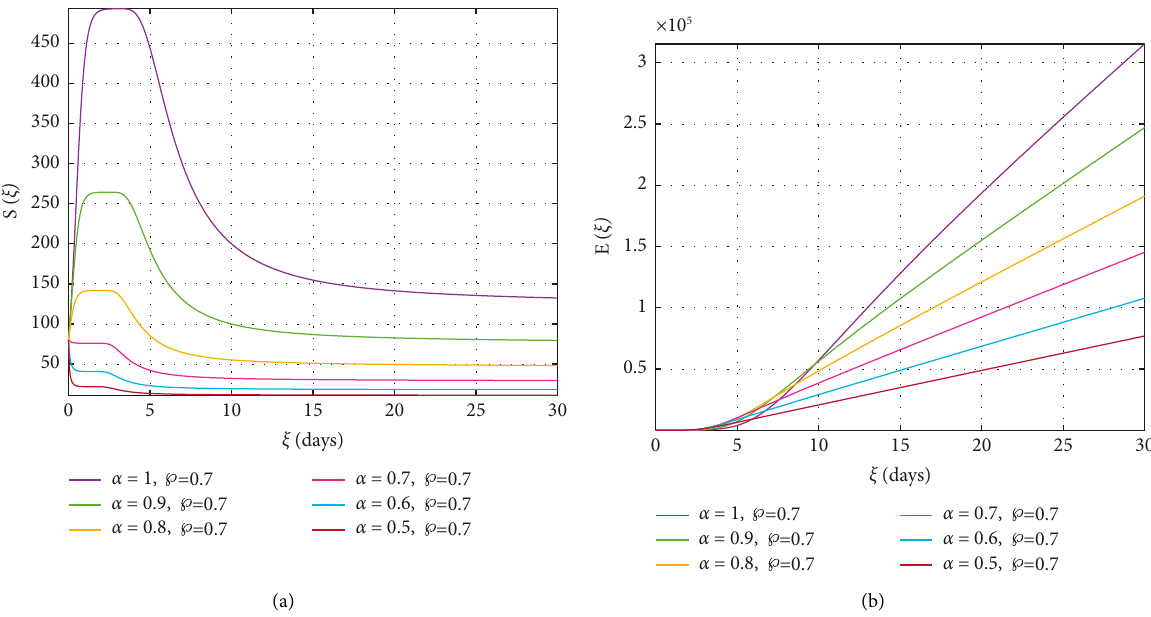
Figure 4: (a) Displays of susceptible individuals S ( ζ ) (b) Displays of exposed individuals E ( ζ ) using a Newton polynomial approach for decreasing fractional-order α and fractal-dimension ℘ � 0 . 7.